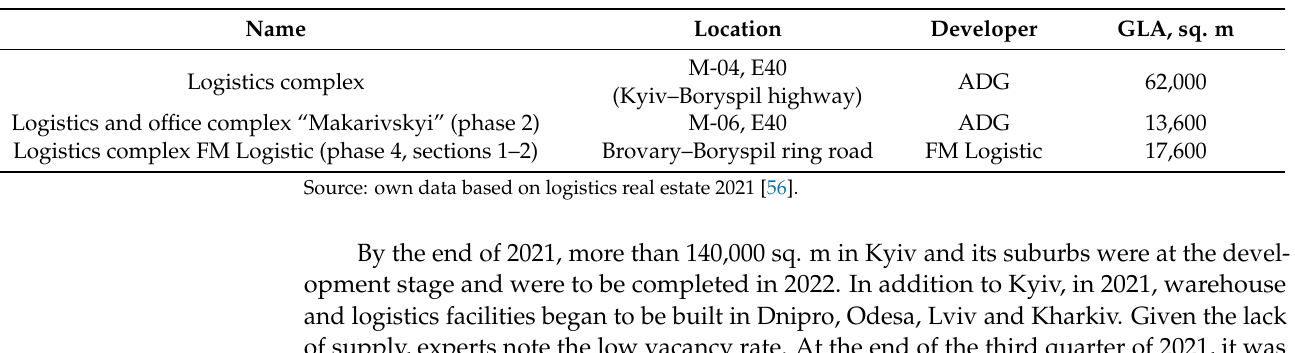
Figure 1. Geographical structure of warehouses built in Ukraine in 2020. Source: own data. In 2021, according to Cushman & Wakefield, 130,000 sq. m appeared on the warehouse and logistics real estate market in Kyiv and in the suburbs of the capital (Table 2). Table 2. Main objects of warehouse and logistics real estate put into operation in Kyiv and its suburbs in 2021.